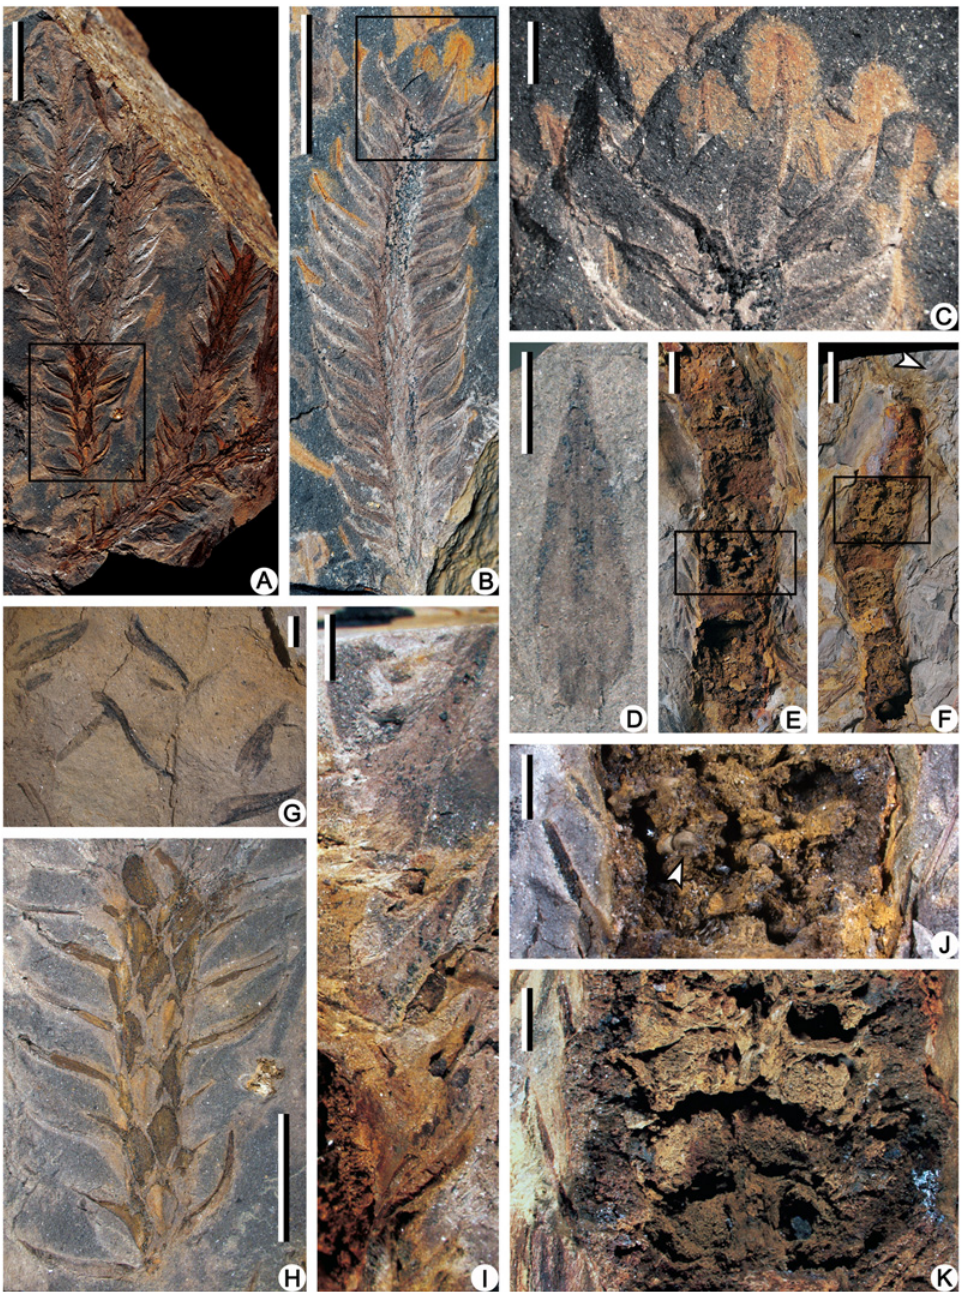
Fig 3. Compressions of leafy axes and leaves (A-D, G, H), limonite permineralized strobili (E, F, I-K) of Minostrobus chaohuensis . (A) Dichotomous vegetative axes with persistent leaves. Rectangle indicating portion enlarged in Fig. 3H. PKUB12124. Scale bar = 10 mm. (B) Distal part of vegetative axis with persistent leaves. Rectangle indicating portion enlarged in Fig. 3C. PKUB12139. Scale bar = 10 mm. (C) Enlargement of Fig. 3B (rectangle), showing the lanceolate leaf in face view. PKUB12139. Scale bar = 2 mm. (D) Lanceolate vegetative leaf in face view. PKUB12159. Scale bar = 2 mm. (E) Limonite permineralized megasporangiate strobilus. Rectangle indicating portion enlarged in Fig. 3J. PKUB12188. Scale bar = 5 mm. (F) Limonite permineralized microsporangiate strobilus. Arrow indicating portion enlarged in Fig. 3I. Rectangle indicating portion enlarged in Fig. 3K. PKUB12189. Scale bar = 10 mm. (G) Detached vegetative leaves in the matrix. PKUB12160. Scale bar = 2 mm. (H) Enlargement of Fig. 3A (rectangle), showing vegetative leaves in lateral view and rhombus leaf bases. PKUB12124. Scale bar = 5 mm. (I) Enlargement of Fig. 3F (arrow), showing laminae of microsporophyll. PKUB12189. Scale bar = 2 mm. (J) Enlargement of Fig. 3E (rectangle). Arrow indicating megaspores. PKUB12188. Scale bar = 2 mm. (K) Enlargement of Fig. 3F (rectangle), showing strobilar axis and microsporangia on the adaxial surface of sporophyll pedicel. PKUB12189. Scale bar = 2 mm.